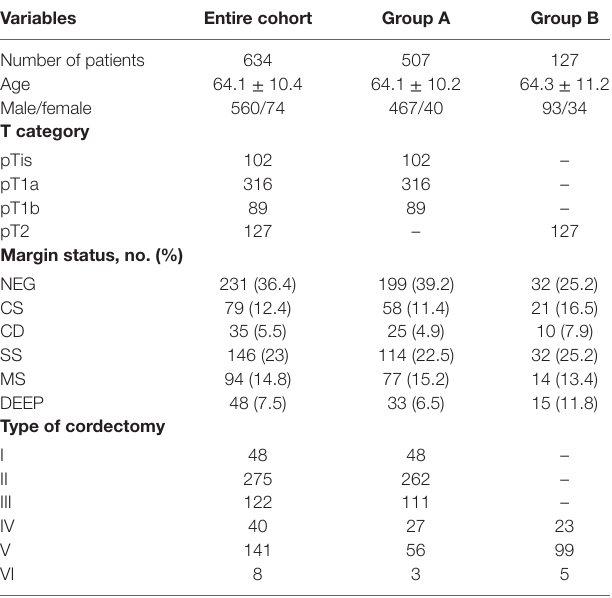
Table 1 | Demographic characteristics, patients’ stratification by pTNM, margin status, and types of cordectomy performed.